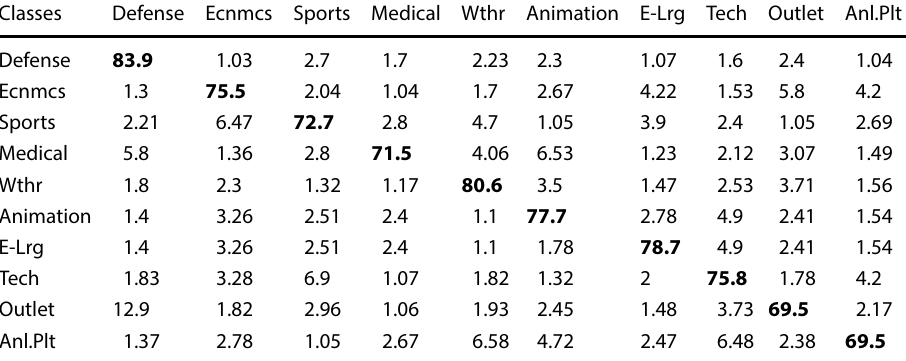
Bold indicates the